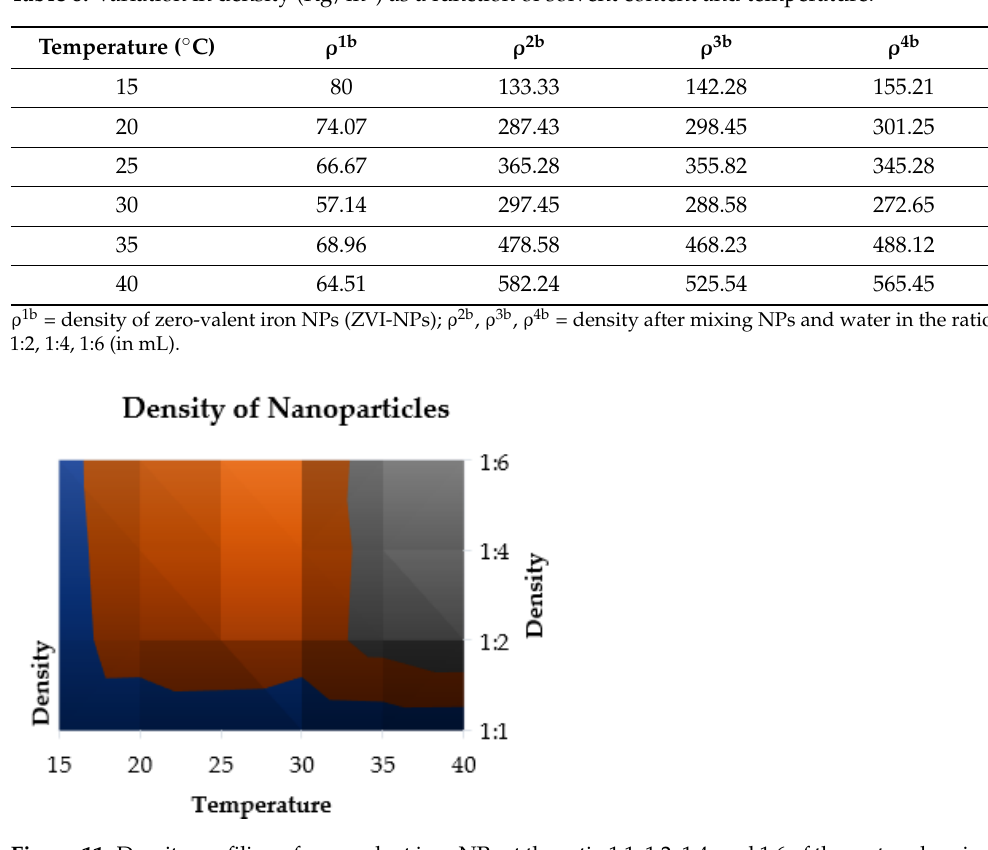
Table 8. Variation in density (Kg/m 3 ) as a function of solvent content and temperature.